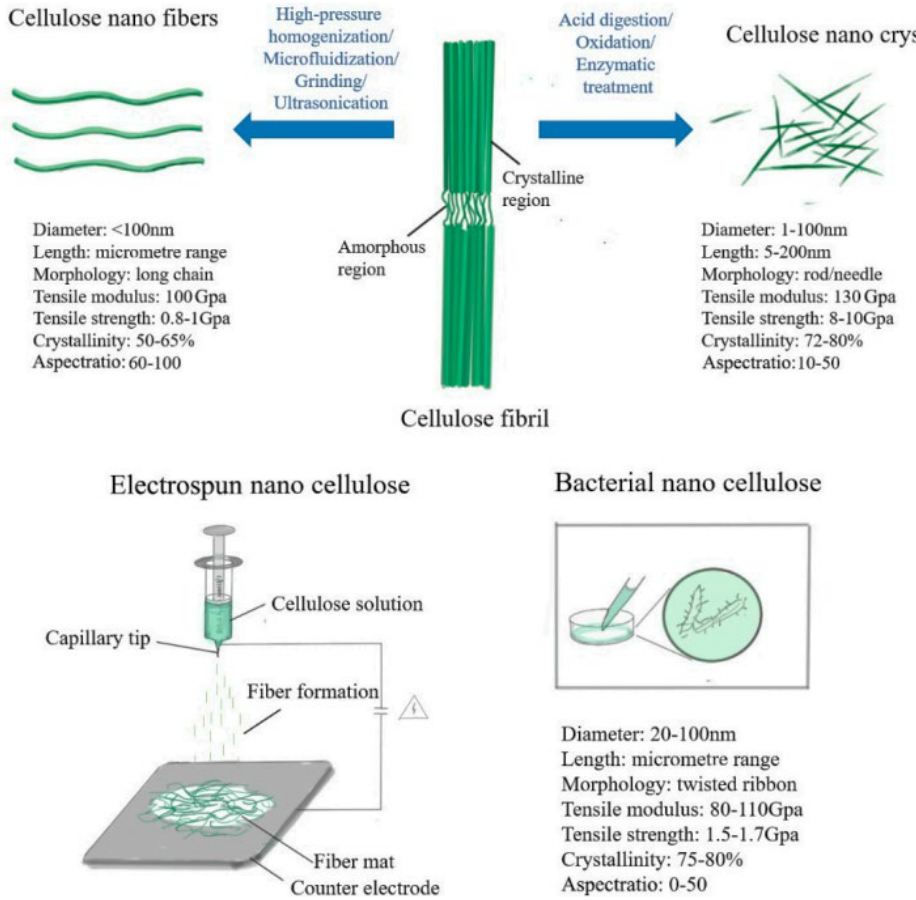
Figure 3. Properties, structure, and synthesis of different types of nanocelluloses